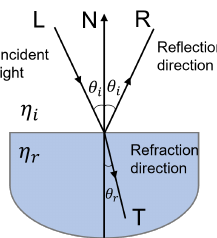
Figure 7. An incident light ray coming from the medium with refractive index η i is reflected and refracted through the directions R and T, respectively, upon a surface with refractive index η r .